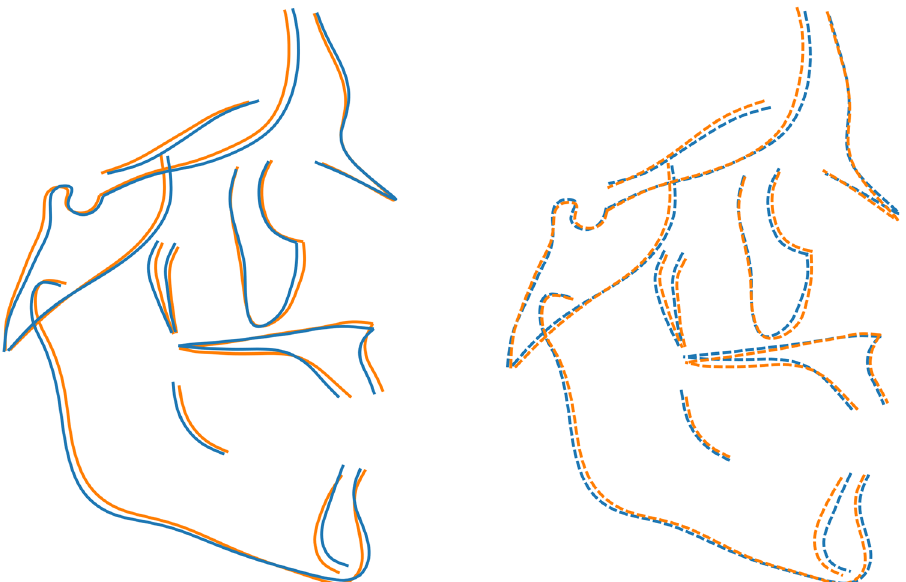
Figure 5. Procrustes superimposition of the average shapes of the craniofacial structures of the βTh (orange) and Ctrl (blue) groups for males (solid line) and females (dotted line)